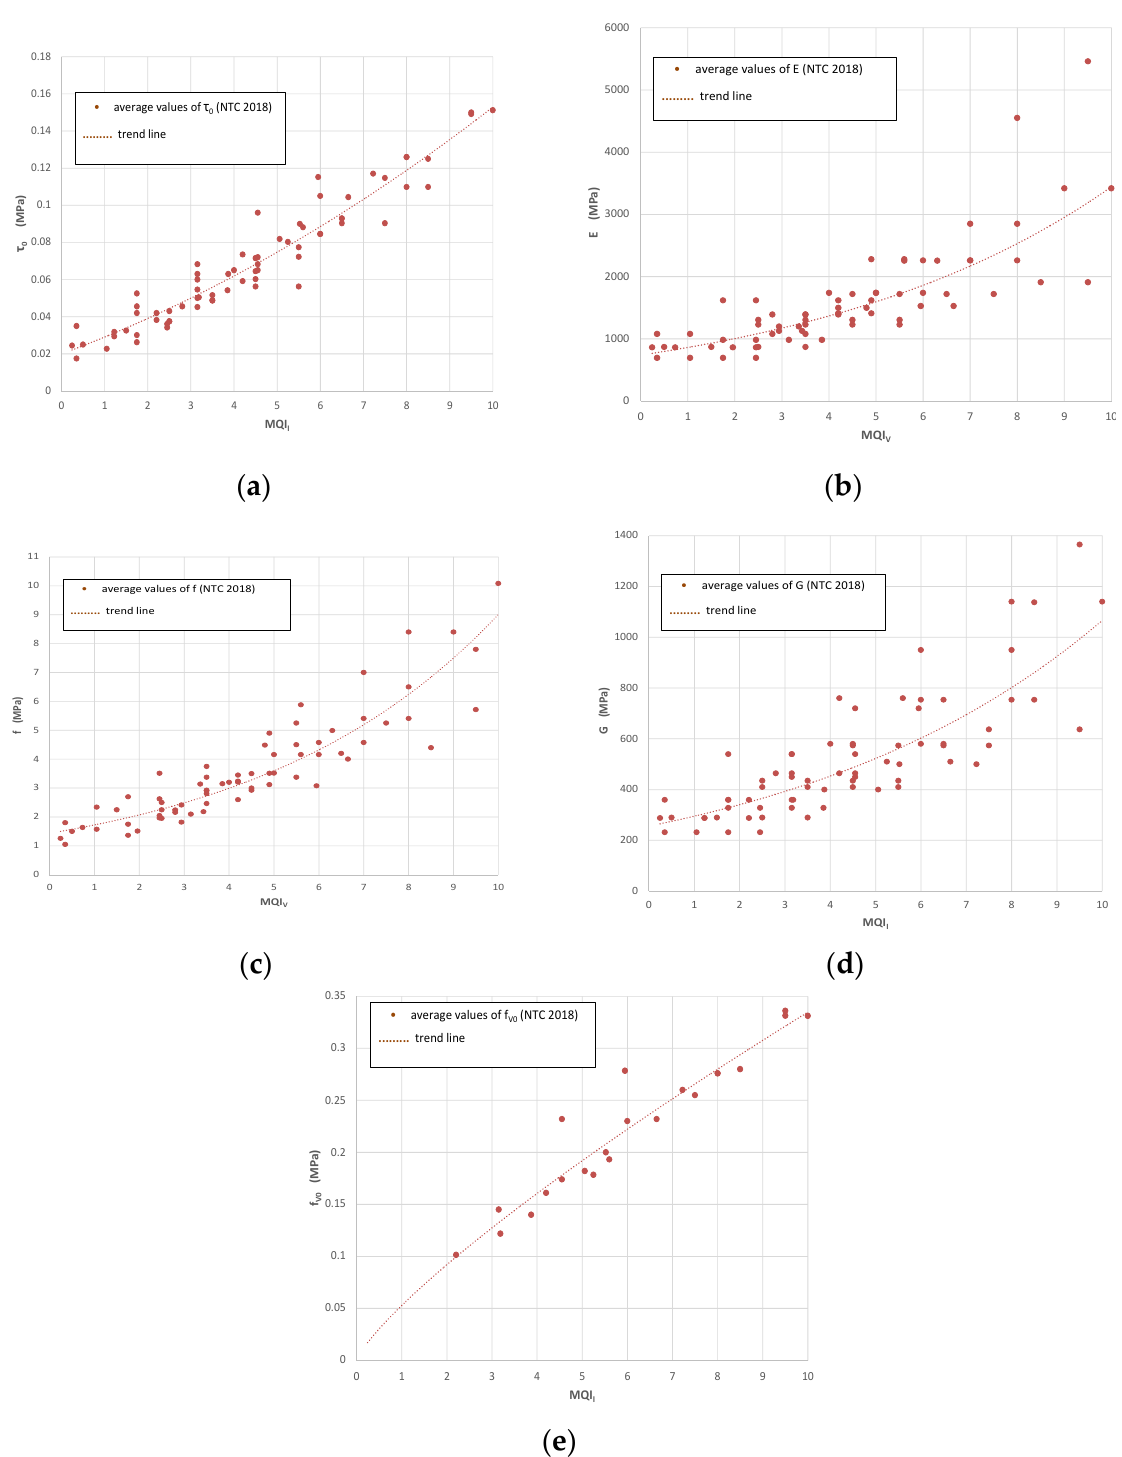
Figure 18. MQI correlations with masonry mechanical parameters: ( a ) Masonry shear strength τ 0 vs. MQI I (NTC 2018, Italian Seismic Code, [40]), ( b ) Masonry Young’s modulus E vs. MQI V , ( c ) Masonry compressive strength f vs. MQI V , ( d ) Masonry shear modulus G vs. MQI I , ( e ) Masonry shear strength f V0 vs. MQI I .